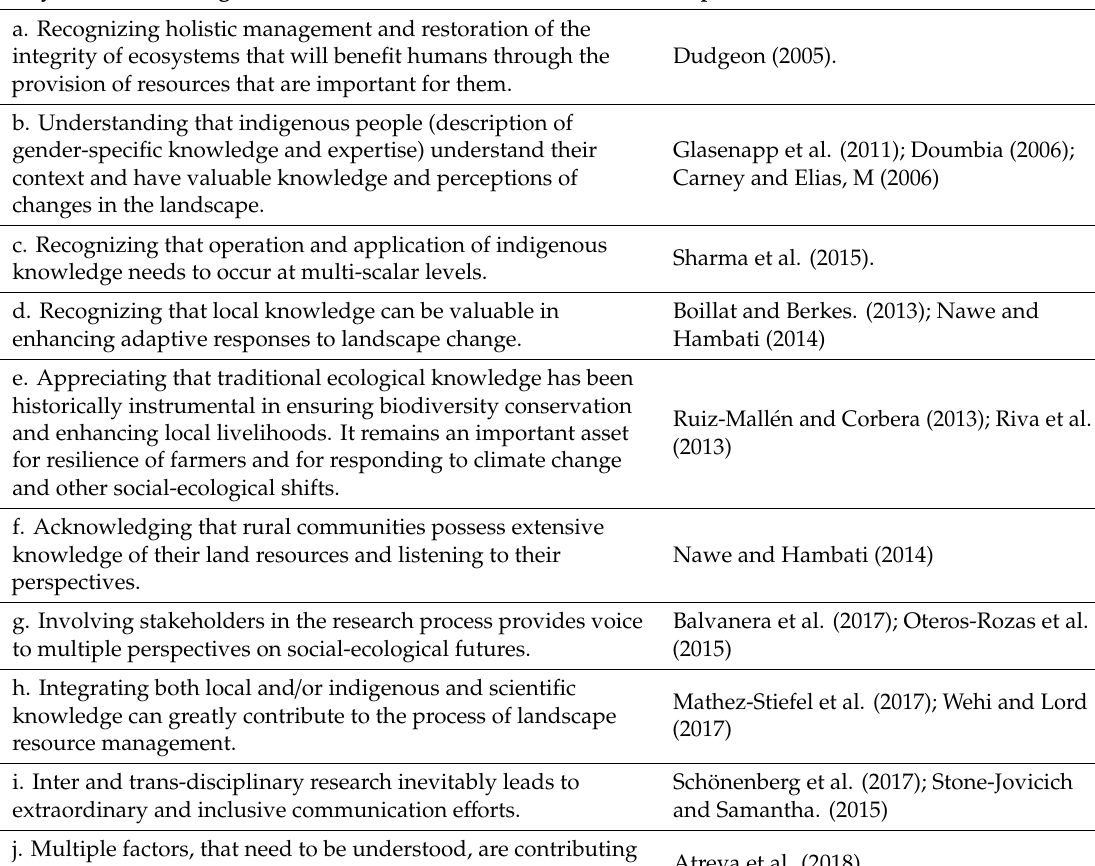
Table 2. Summary of key success factors, concepts and lessons from landscape studies that have integrated